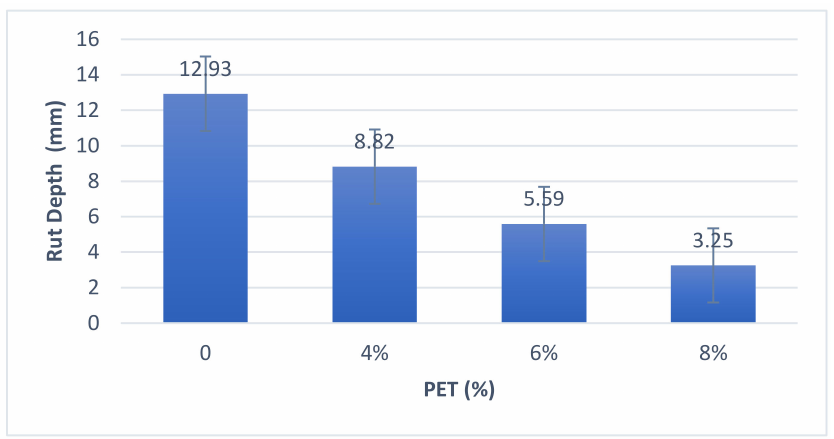
Figure 9. Rutting results vs. PET plastic